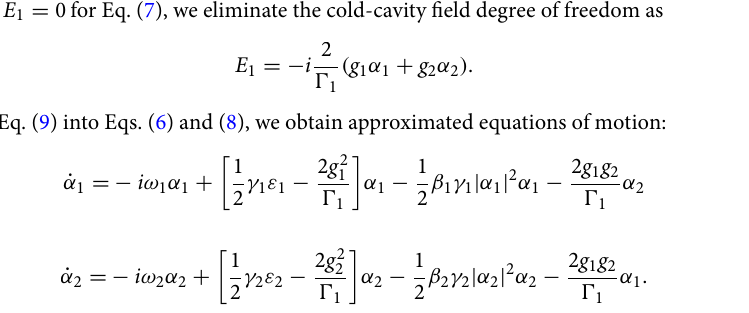
and pump parameters, as (cid:31) 1 ≡ − γ 1 ǫ 1 / 2 + i ω 1 , (cid:31) 2 ≡ − γ 2 ǫ 2 / 2 + i ω 1 , and � 1 ≡ Ŵ 1 / 2 + i � 1 , respectively. Here, the oscillation frequencies ω 1 , ω 2 , and (cid:31) 1 are the imaginary parts of the effective decay rates. First, as pointed